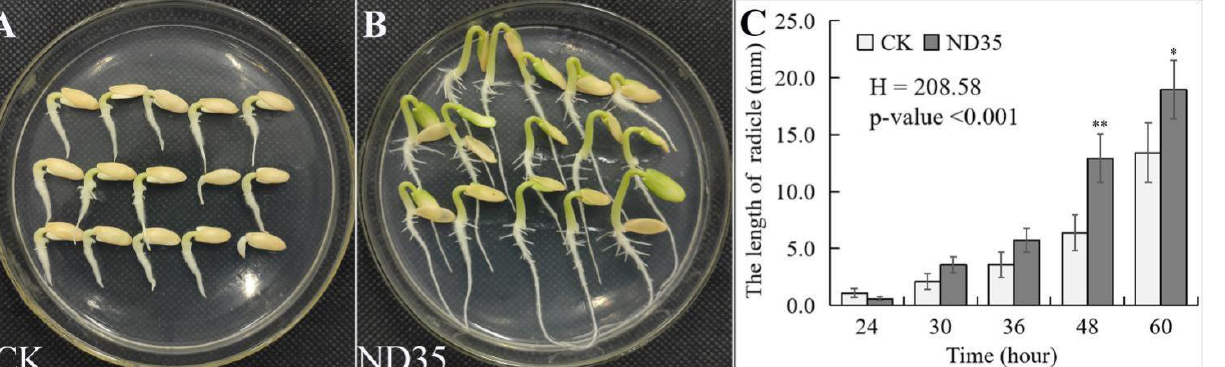
Figure 1. Effect of C. globosum strain ND35 on the radicle length of cucumber. ( A ): The radicle length of cucumber treated without strain ND35 at 48 h; ( B ): The radicle length of cucumber treated with strain ND35 at 48 h; ( C ): The time course of radicle length in different treatment. The spore concentration of C. globosum strain ND35 was 1 × 10 6 spores/mL. * indicates significant differences at p < 0.05, ** indicates significant differences at p < 0.01 (by t -test), the below is same.